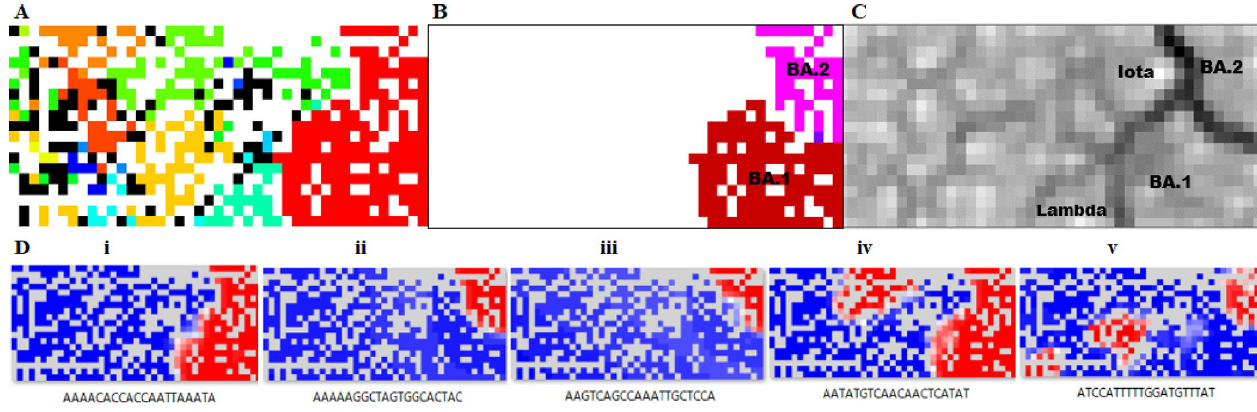
Fig 2. BLSOM for 1169 Omicron 20-mers. (A) The total number of nodes (grid points) was set to approximately 1/100 of the total number of genomes: 817 nodes. Nodes that included sequences from more than one lineage are indicated in black, and those containing sequences from a single lineage are shown in the following lineage-specific color with the number of genomes in parentheses: Omicron ( ■ , 9191), Alpha ( ■ , 10,000), Beta ( ■ , 8978), Delta ( ■ , 10,000), Epsilon ( ■ , 10,000), Eta ( ■ , 2304), Gamma ( ■ , 10,000), Iota ( ■ , 10,000), Kappa ( ■ , 2924), L ( ■ , 125), Lambda ( ■ , 1942), Mu ( ■ , 3889), S ( ■ , 271), Theta ( ■ , 155), V ( ■ , 28) and Zeta( ■ , 1422). Nodes that included no sequences were left in blank (white). (B) Mapping of newly downloaded BA.1 and BA.2 sequences on the BLSOM presented in A. (C) U-matrix. BA.1, BA.2, Alpha and Iota territories, which are visually separated by black lines of the U-matrix, are specified. (D) Heatmaps for five 20-mers. Those for all 1169 20-mers are presented in S1